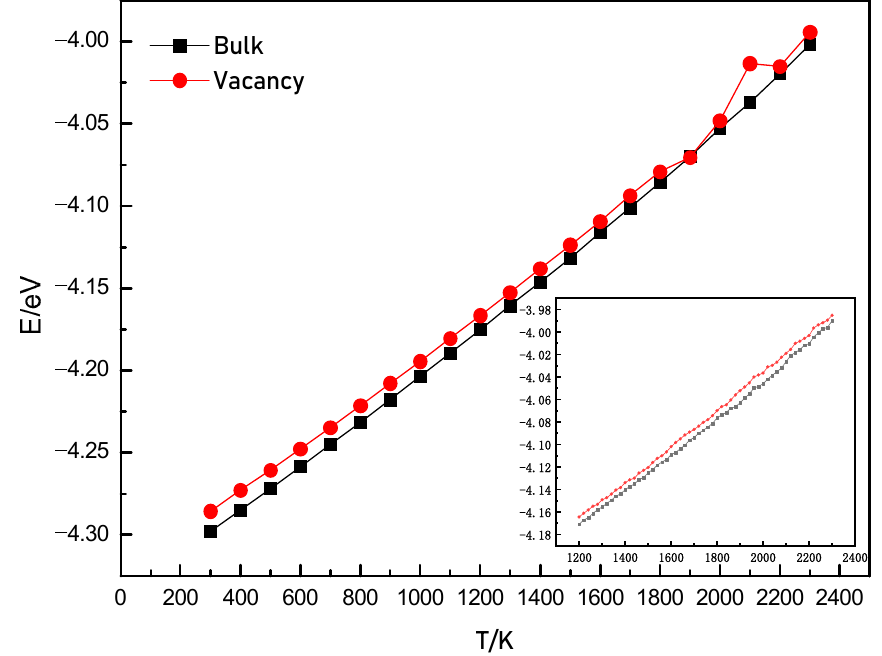
Figure 2. The average potential energy per atom varying with the